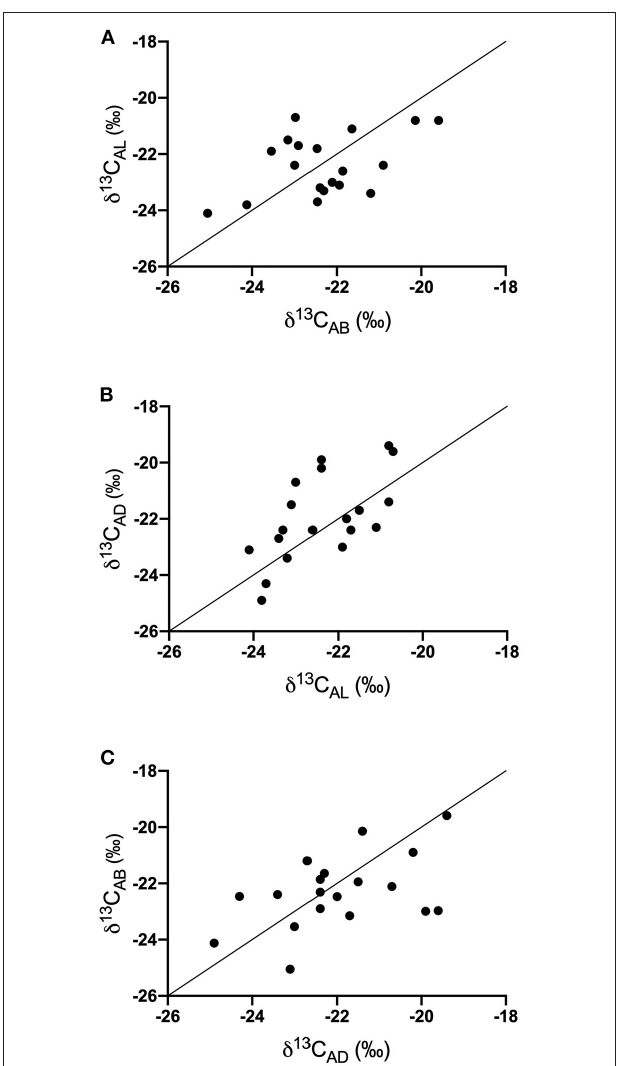
FIGURE 1 | Covariation of δ 13 C values of exhaled breath samples throughout the day (A) AB vs. AL, (B) AL vs. AD, and (C) AD vs. AB. Solid line represents the 1:1